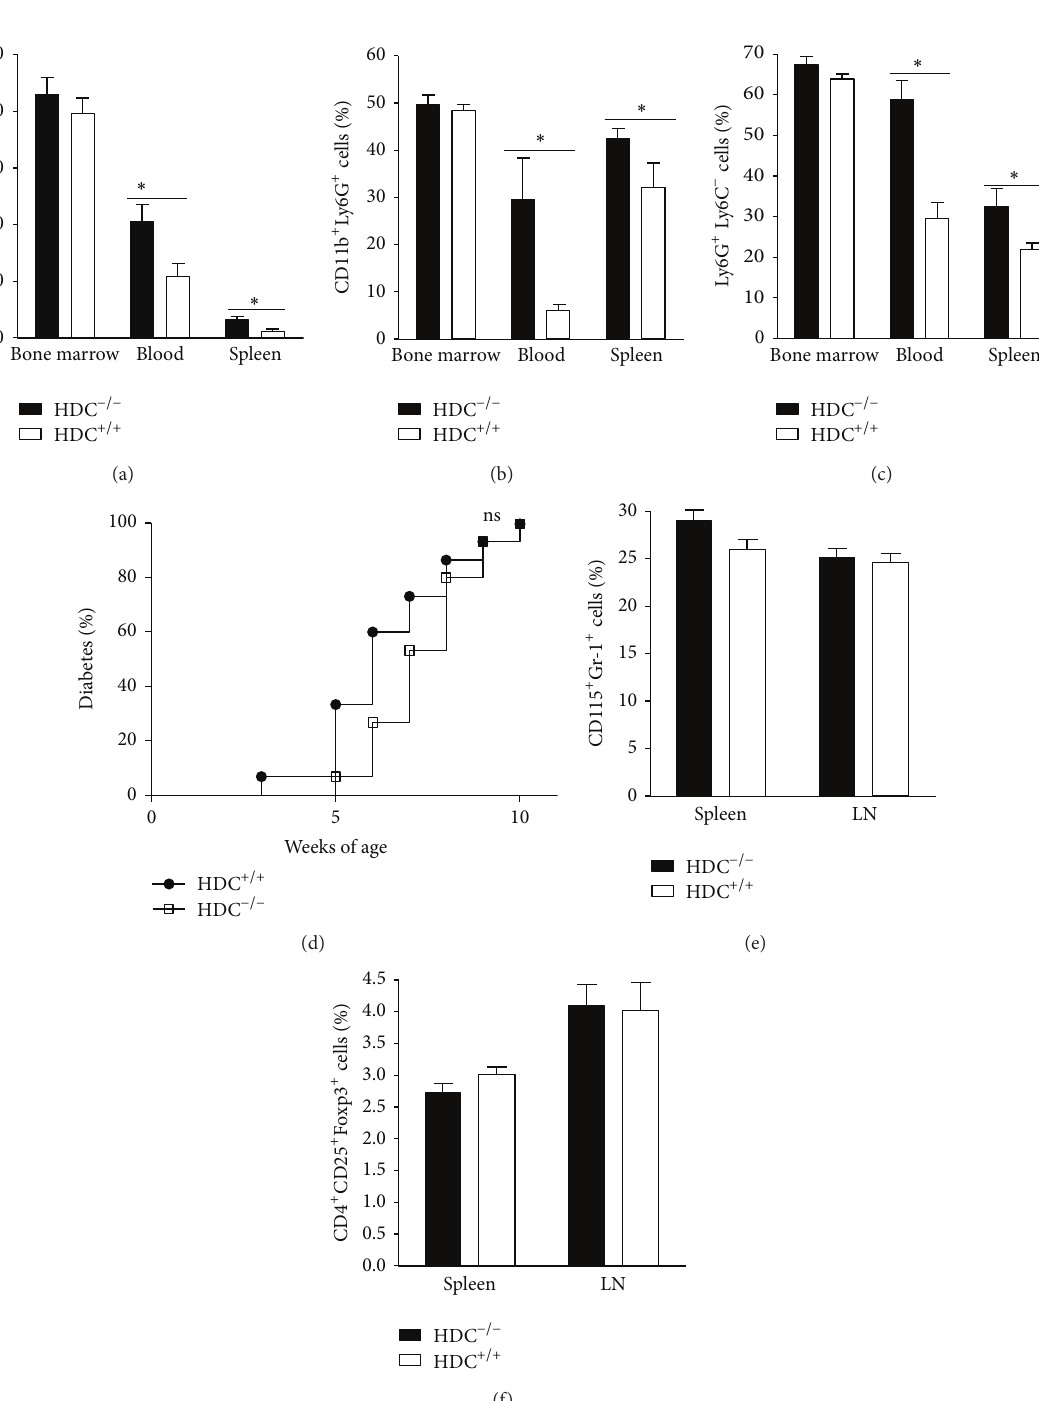
Figure 2: HDC deficiency increases CD11b + Gr-1 + and CD11b + Ly6G + IMCs. (a) The percentages of CD11b + Gr-1 + IMCs in BM, spleen, and peripheral blood in wild-type and HDC −/− mice were measured by FACS analysis ( ∗ 𝑃 < 0.05 ; mean ± s.d. 𝑛 = 5 for each group). (b) The relative proportion of CD11b + Ly6G + cells in bone marrow, peripheral blood and spleen from wild-type and HDC −/− mice measured by FACS analysis ( ∗ 𝑃 < 0.05 ; mean ± s.d. 𝑛 = 5 for each group). (c) The relative proportion of Ly6G + Ly6C − cells in bone marrow, peripheral blood and spleen of wild-type and HDC −/− mice measured by FACS analysis ( ∗ 𝑃 < 0.05 ; mean ± s.d. 𝑛 = 5 , each group). (d) Bone marrow-derived IMCs from HDC −/− do not accelerate diabetes onset. Incidence diabetes was measured in NOD RAG −/− mice after adoptive transfer of pathogenic lymphocytes and CD11b + BM-derived IMCs from wild-type mice or HDC −/− mice ( 𝑛 = 15 , ∗ 𝑃 < 0.05 compared to indicated control). (e) The percentages of Gr-1 + CD115 + MDSCs in spleen and pancreatic LNs in wild-type and HDC −/− mice were measured by FACS analysis ( ∗ 𝑃 < 0.05 ; mean ± s.d. 𝑛 = 5 for each group). (f) Percentages of CD4 + CD25 + Foxp3 + regulatory T cells in spleen and pancreatic LNs in wild-type and HDC −/− mice were measured by FACS analysis ( ∗ 𝑃 < 0.05 ; mean ± s.d. 𝑛 = 5 for each